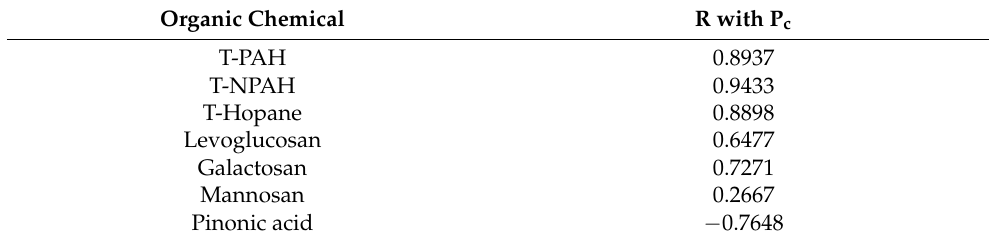
Table 4. Correlation coefficients (R) of the organic chemicals with P